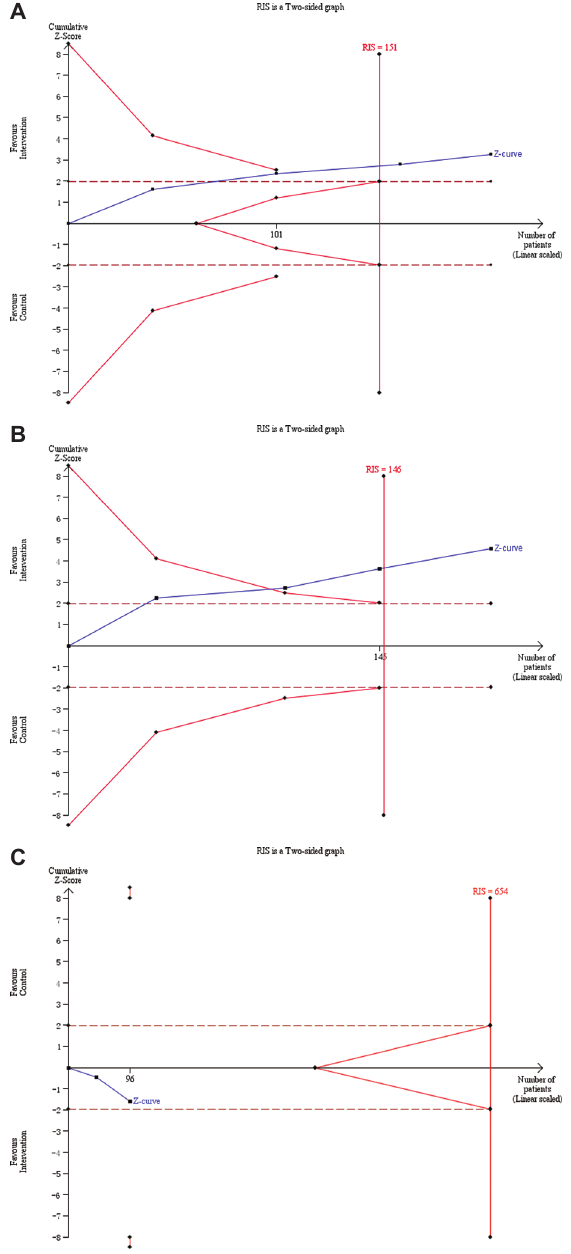
Figure 4. Outcomes of Trial Sequential Analysis. A. Anxiety B. Stress C.